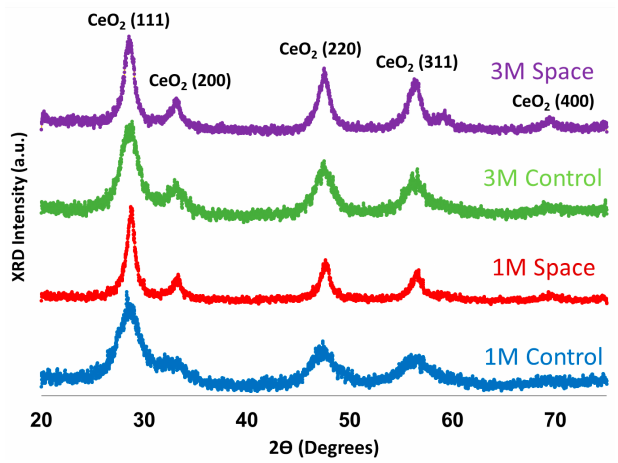
Figure 6. XRD pattern of the CeO 2 sample.